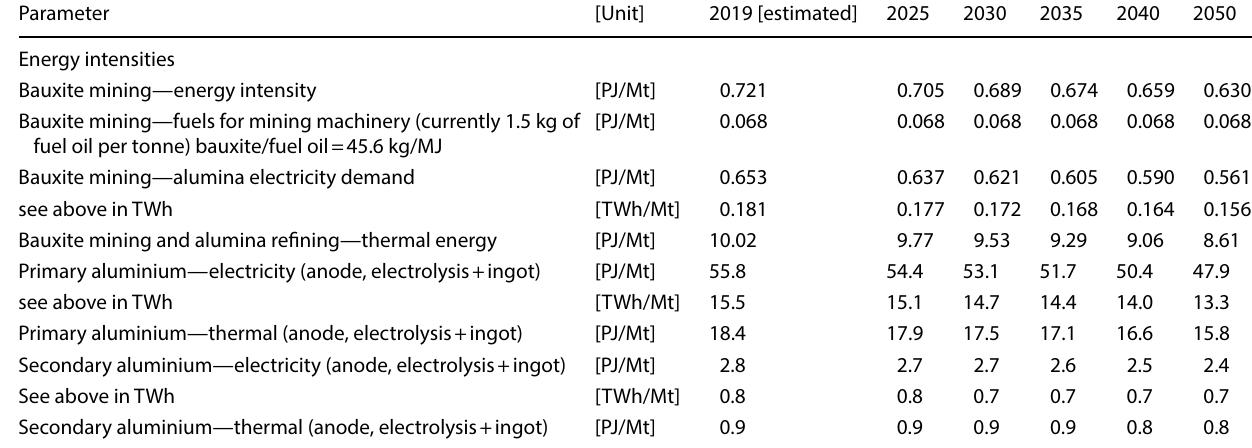
Table 7 Assumed energy intensities for bauxite mining and aluminium production processes